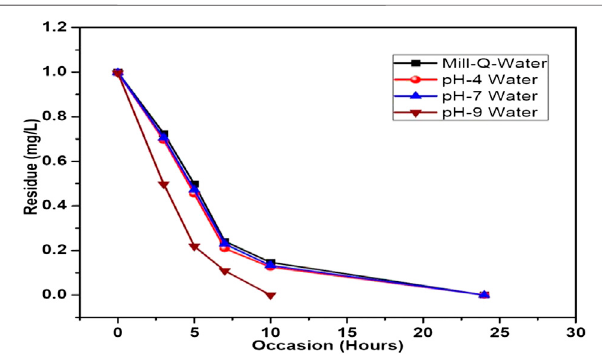
FIGURE 14 | Graph representing the dissipation curve of photocatalytic decontamination of fl umioxazin in water under direct sunlight.